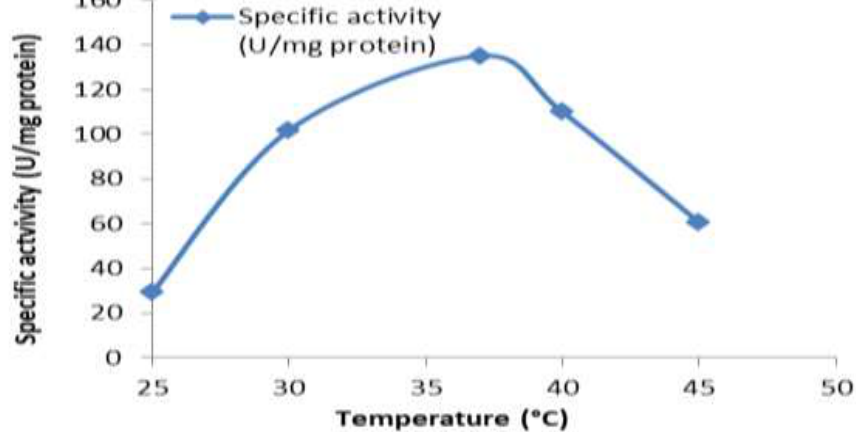
Figure 5: Optimum temperature for enzyme production.